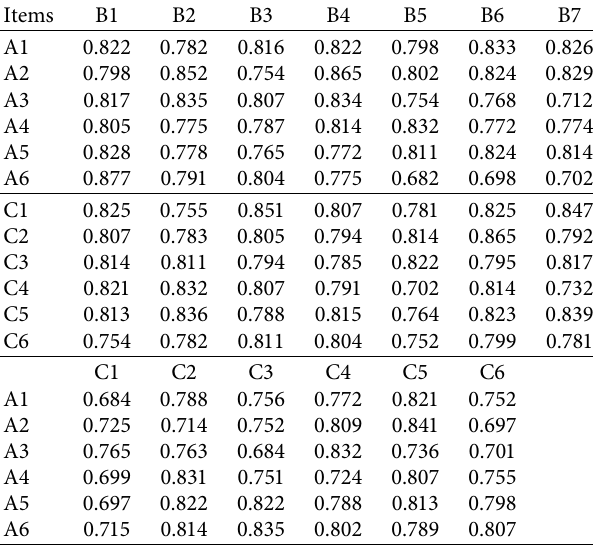
Table 2: Pearson correlation values ( r ) for RO4 and RO5